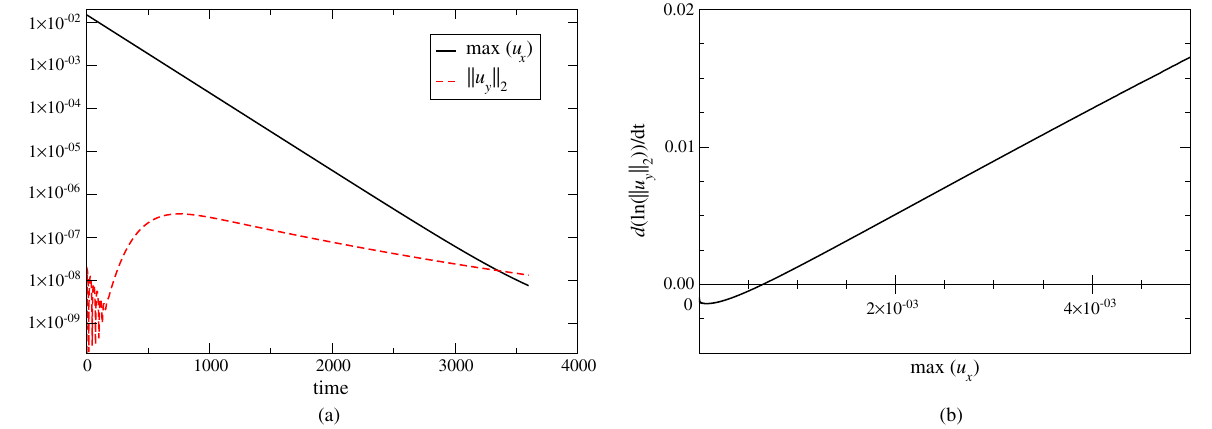
k Þ . The zero of (b) versus max ð u y x 2